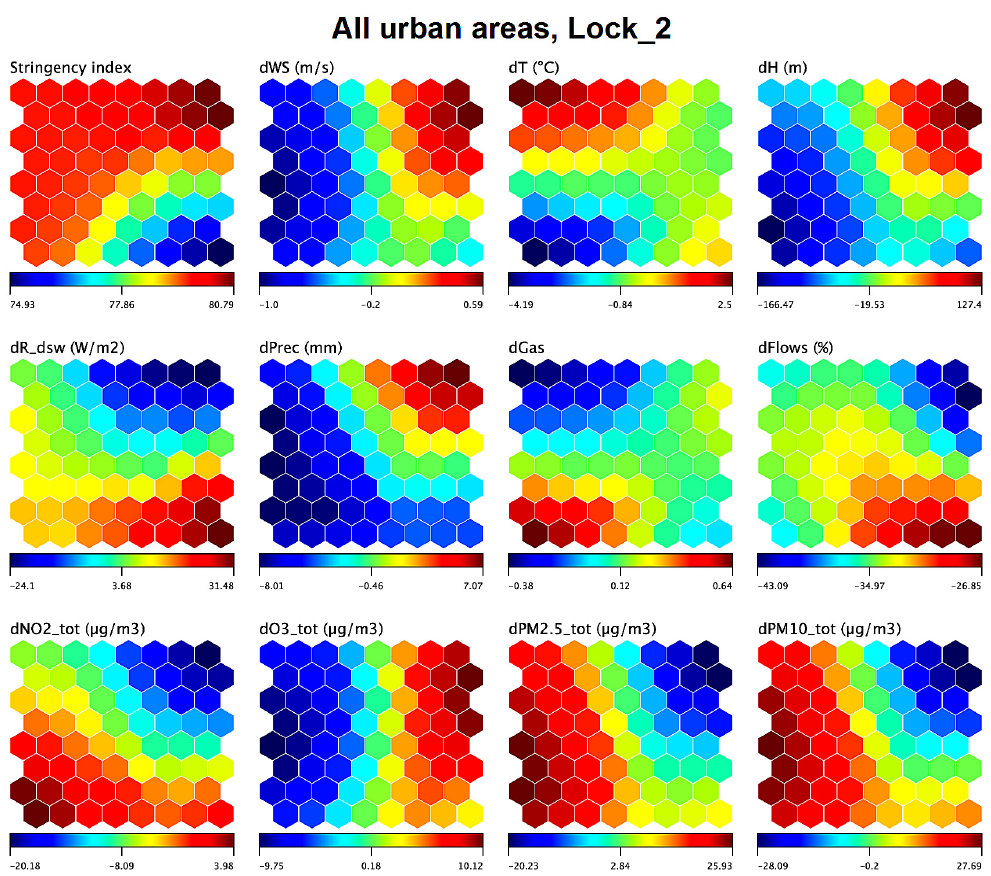
Figure 6. SOM component planes obtained in the urban areas of Turin, Milan, Bologna, and Florence during the Lock_2 period (23/10/2020 − 29/12/2020) from daily observations. The 12 panels report the 2020 Stringency index and the absolute difference of meteorological variables ( WS , T , H , R_dsw , and Prec ), anthropogenic emission drivers ( Gas and Flows ), and total pollutant concentrations (NO 2 , O 3 , PM 2.5 , and PM 10 ) with respect to the 2019 baseline period (25/10/2019 − 31/12/2019). For 2020 vs. 2019 absolute differences, positive (negative) values mean increases (decreases). The panels are linked by position, so the hexagons in a certain position correspond to the same map unit.